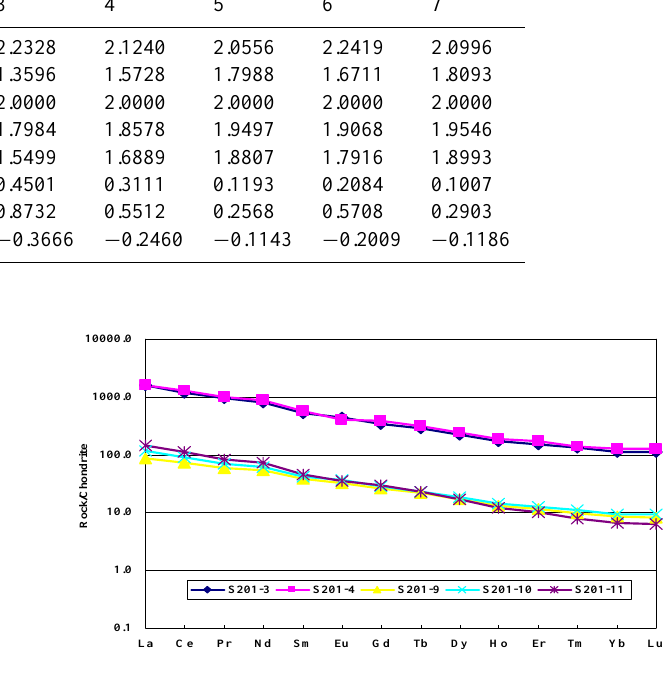
Table 3. Multifractal parameters for characterizing the spatial structures of the pyrrhotite particles’ areas. Basalt segment